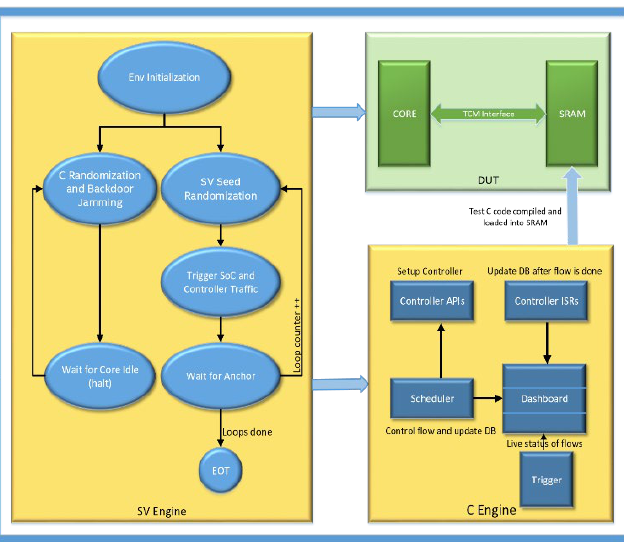
Fig. 2. Architectural view of the proposed